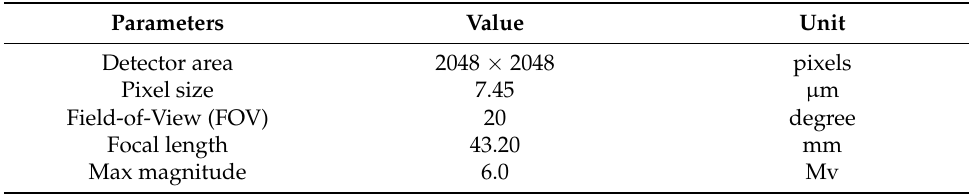
Table 2. Star tracker parameters.